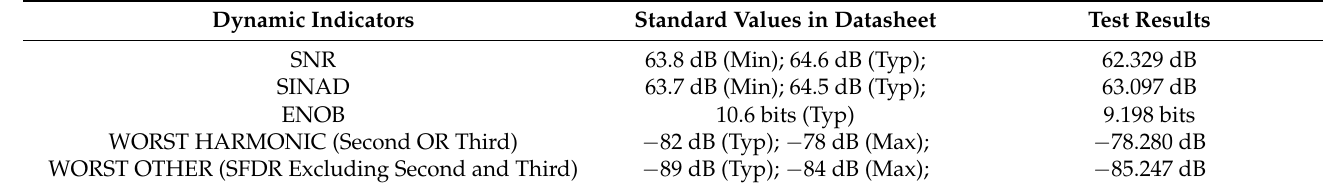
Table 3. Results of the AD9320 test.